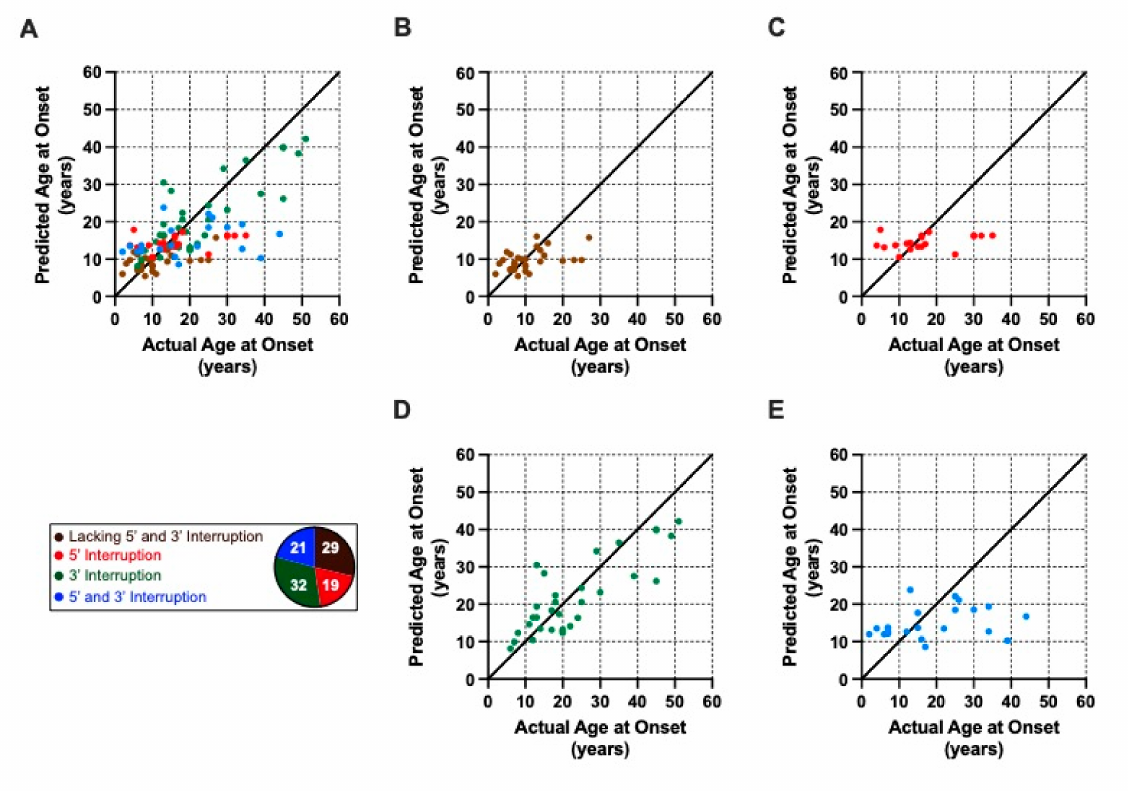
Figure 4. Predicted versus actual ages at disease onset for a given number of GAA1 repeats. ( A ) Actual and predicted ages at disease onset for the whole FRDA cohort ( n = 101). The subgroup membership is colour-coded according to the legend, which also indicates the number of patients per subgroup. ( B – E ) show the predicted versus actual age at disease onset for each subgroup separately. In each graph, the solid black line indicates identical predicted and actual ages at disease onset.